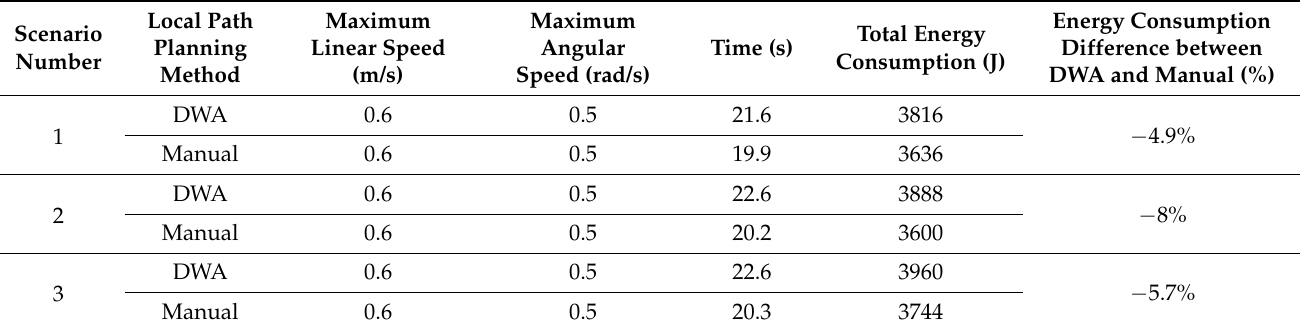
Figure 6. ( a ) SGV’s paths in the experiments. (Red and blue trajectories show the paths generated by manual control and DWA, respectively); ( b ) SGV’s power consumption in the experiments. Table 4. Summary of the experimental